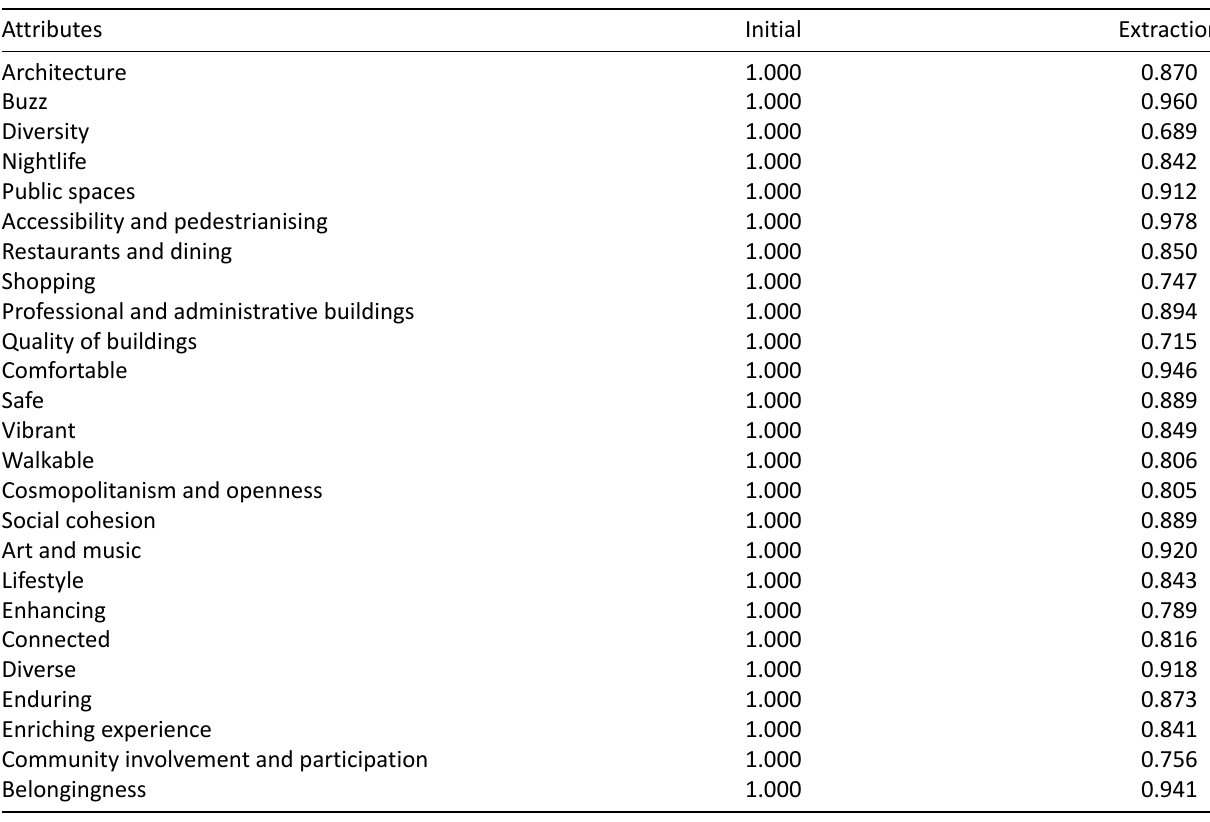
Table 5. Communalities.